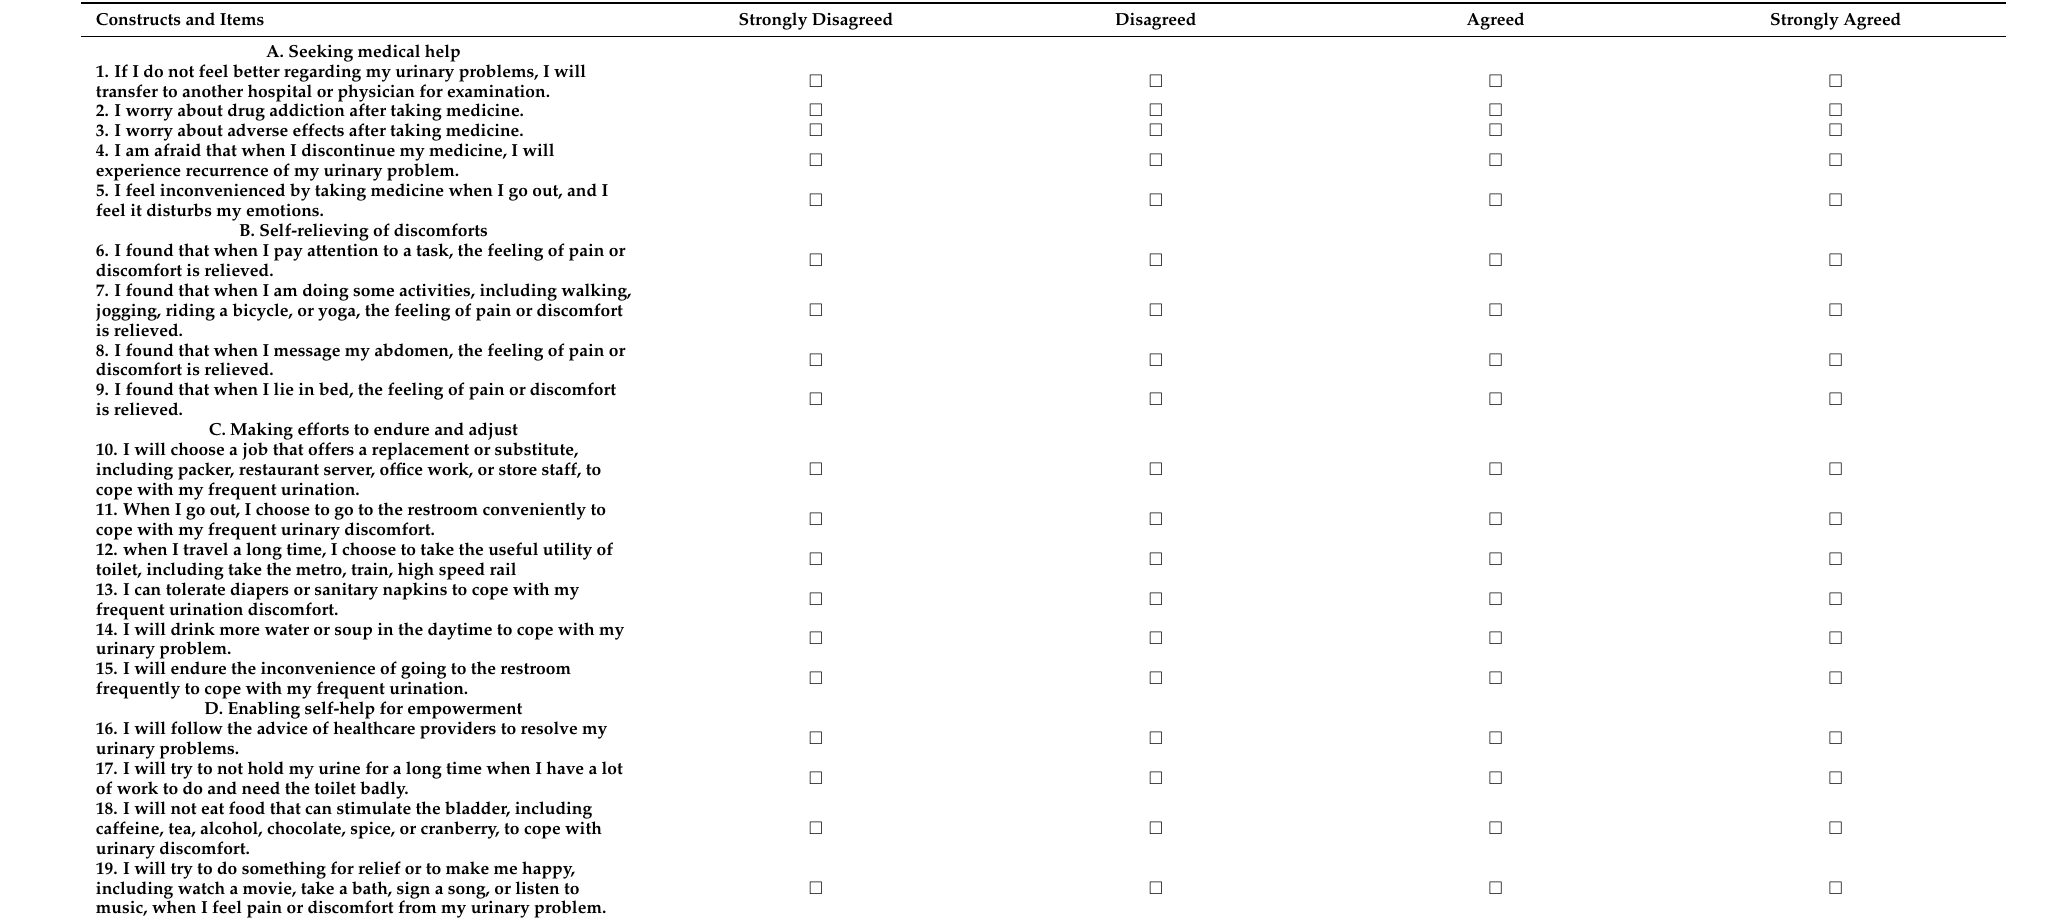
Table A1. IC Self-Help and Medical Resources Scale